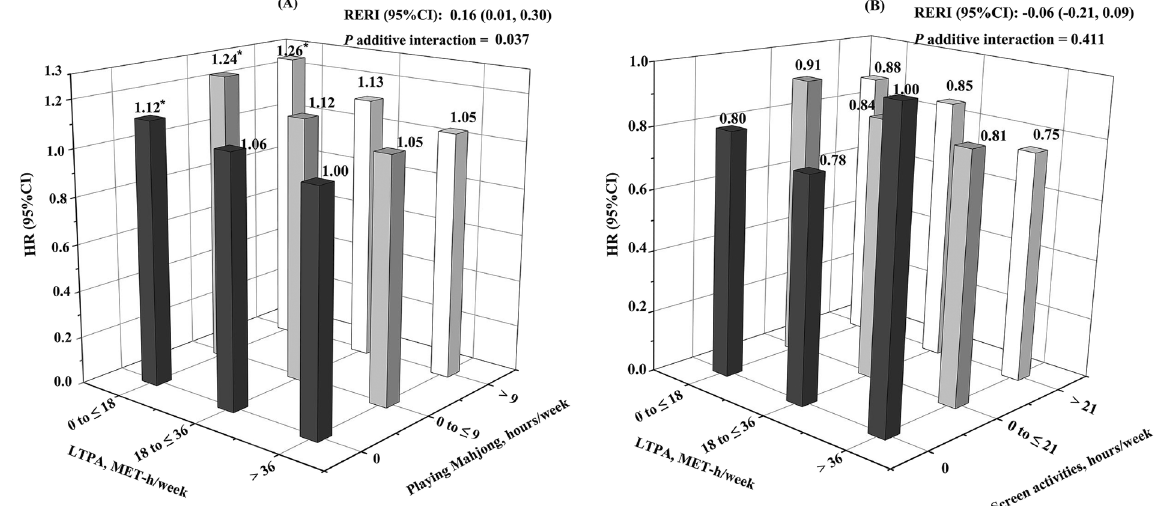
Figure 3. The joint effect of LTPA and sedentary behavior on incident CVD. ( A ) The joint effect of LTPA and Mahjong playing on incident CVD. ( B ) The joint effect of LTPA and screen activities on incident CVD. The multivariable models were adjusted for age, sex, education, smoking status, alcohol intake, consumption of food (meat, vegetables, and fruit), hypertension, hyperlipidemia, diabetes, BMI, MET-hours/week, and family history of CVD. * P < 0.05. † The number was 26,354 for Mahjong and incident CVD analysis; the number was 26,558 for screen activities and incident CVD analysis. ‡ The hazard ratios (95% CI) from the most active to the least active group were: 1 (reference), 1.06 (1.00 to 1.16), 1.12 (1.01 to 1.24), 1.05 (0.90 to 1.21), 1.12 (0.96 to 1.30), 1.24 (1.07 to 1.44), 1.05 (0.90 to 1.21), 1.13 (0.97 to 1.32), 1.26 (1.08 to 1.47), respectively, in ( A ). ¶ The hazard ratios (95% CI) from the most active to the least active group were: 1 (reference), 0.78 (0.45 to 1.35), 0.80 (0.51 to 1.25), 0.81 (0.57 to 1.14), 0.84 (0.59 to 1.19), 0.91 (0.64 to 1.30), 0.75 (0.53 to 1.07), 0.85 (0.60 to 1.22), 0.88 (0.61 to 1.25), respectively, in ( B